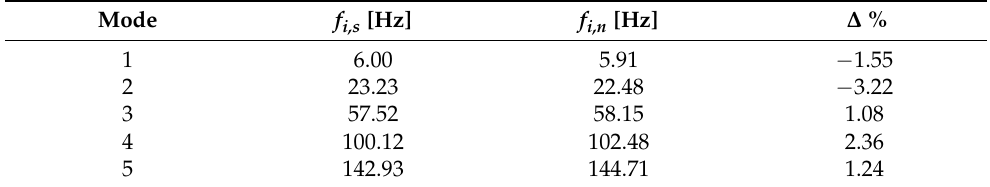
Figure 8. Quadratic error e as a function of the elastic modulus for the simply supported beams. Table 4. Comparison between experimental eigenfrequencies of the simply supported beam and the corresponding numerical ones with the optimal value of the longitudinal elastic modulus E = 205 GPa.